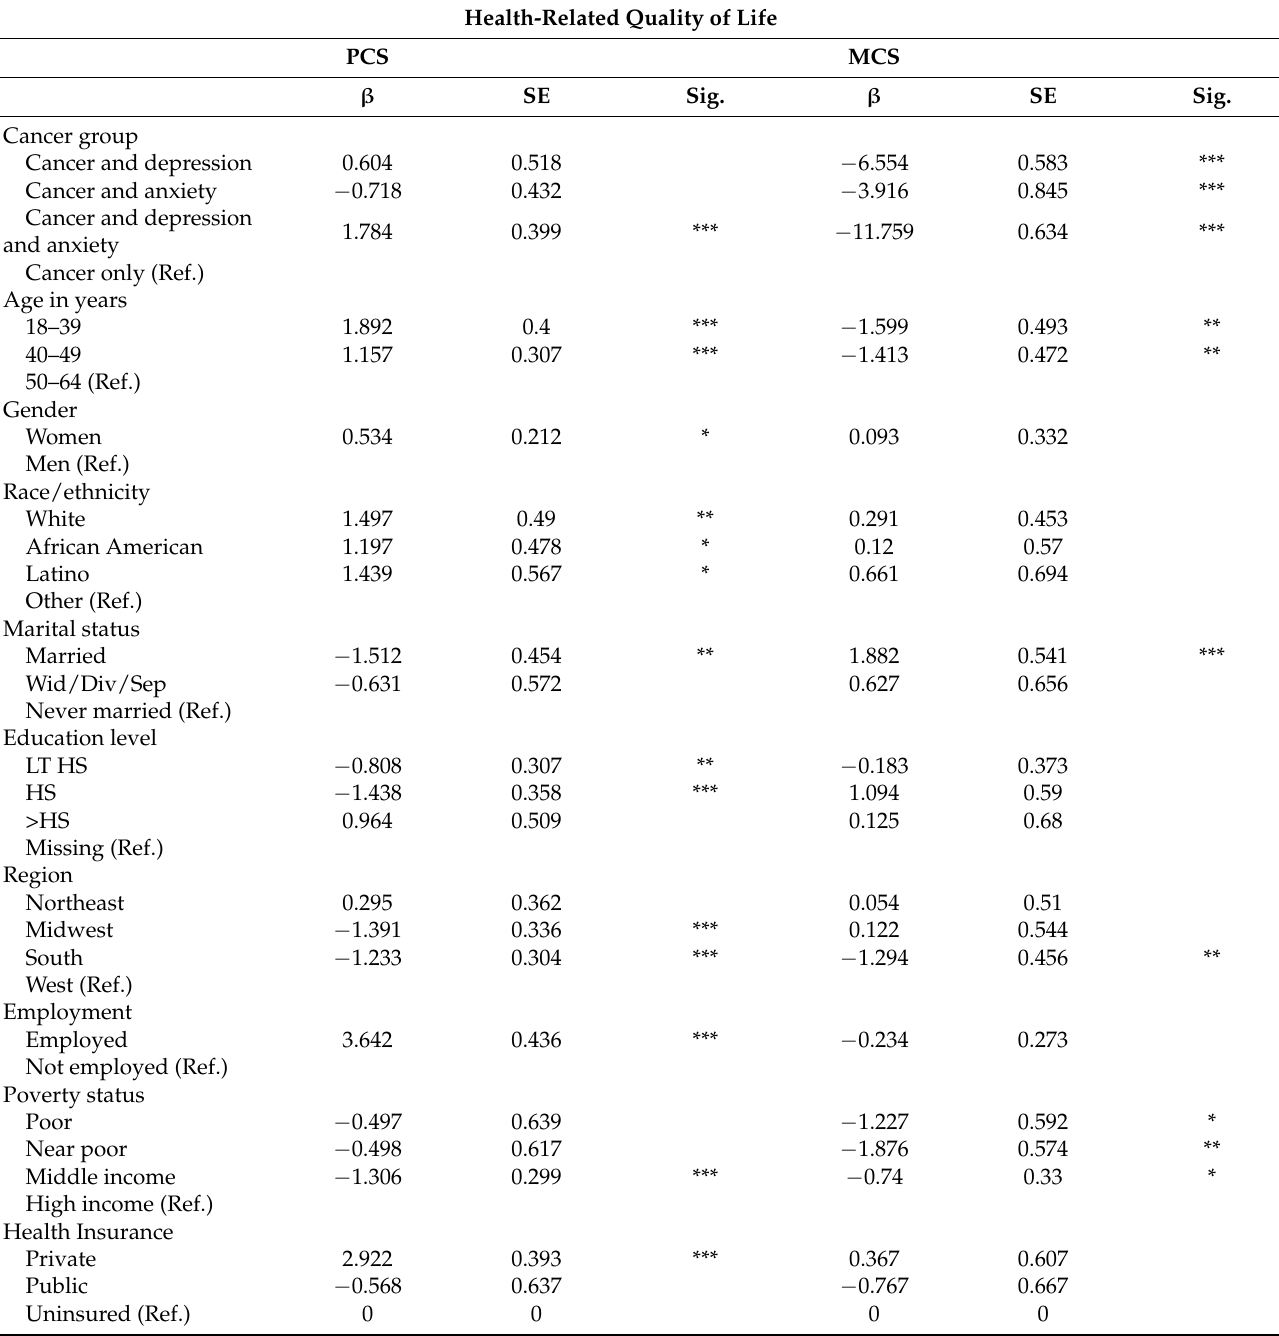
Table 3. Parameter estimates and standard errors from multivariate linear regressions on HRQoL among adults with cancer, Medical Expenditure Panel Survey